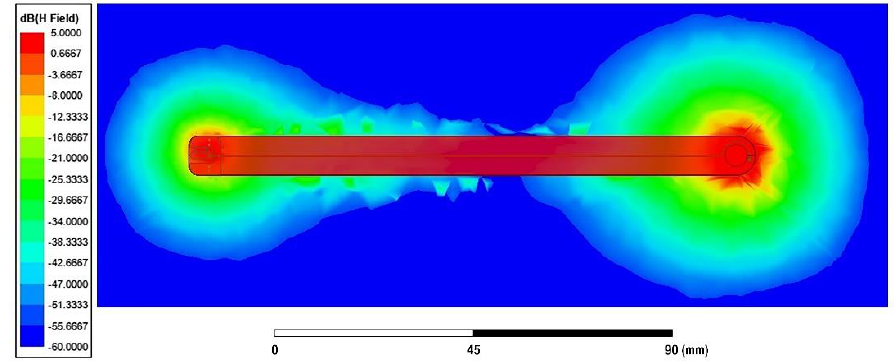
Figure 11. Simulation of the spatial magnetic field strength H in the XY plane (parallel to the NFP-PCB).